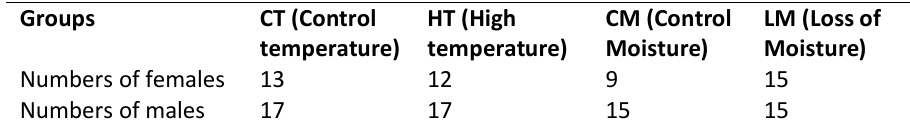
Table 1 - Numbers of individuals on which we measured quality